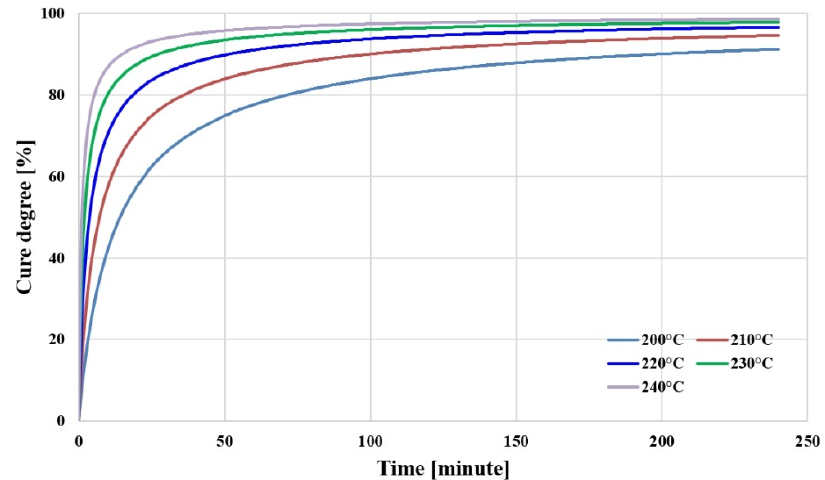
Figure 1. Cure degree of PPG as a function of temperature and